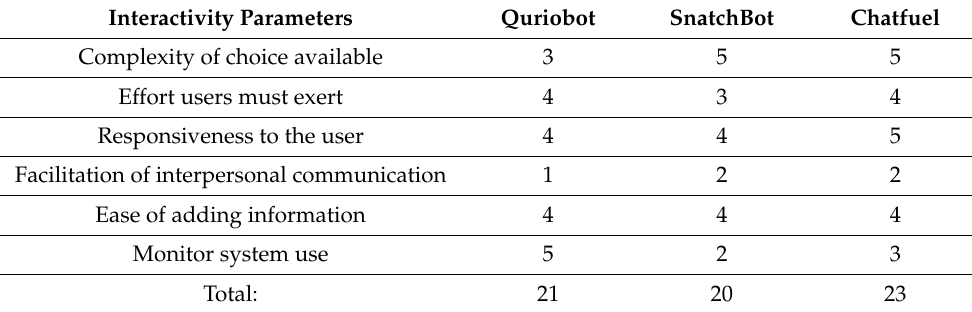
Table 1. Chatbot creation platforms and their interactivity features ranked. Interactivity Parameters Quriobot SnatchBot Chatfuel Complexity of choice available 3 5 5 Effort users must exert 4 Responsiveness to the user 4 4 Facilitation of interpersonal